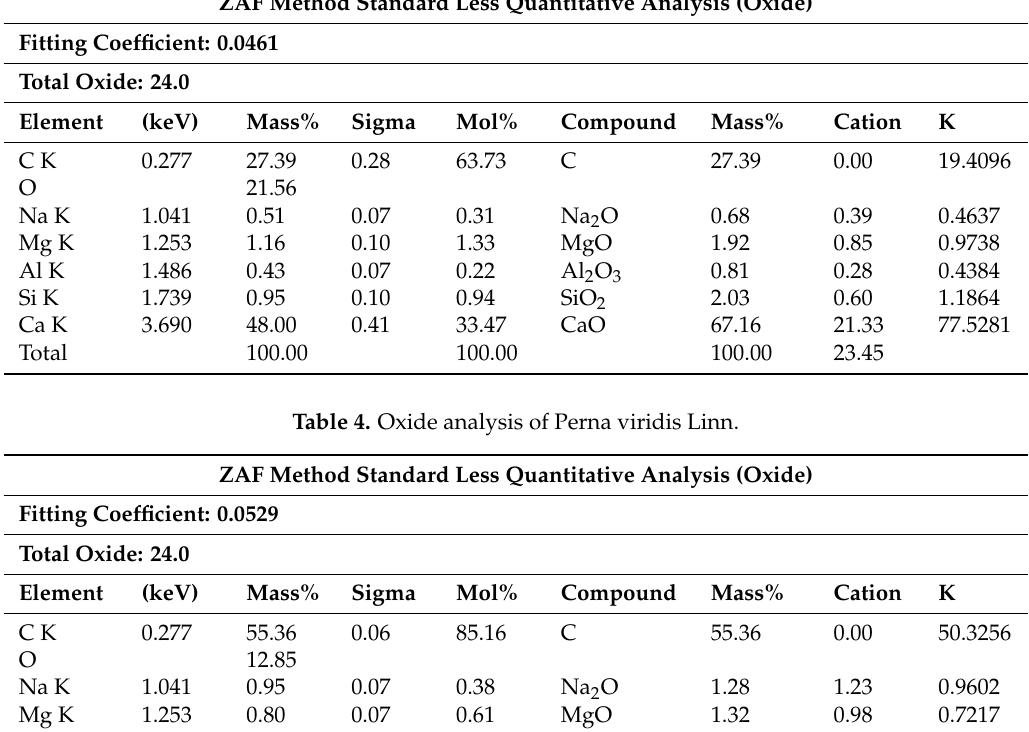
Table 3. Oxide analysis of Anadara granosa Linn.